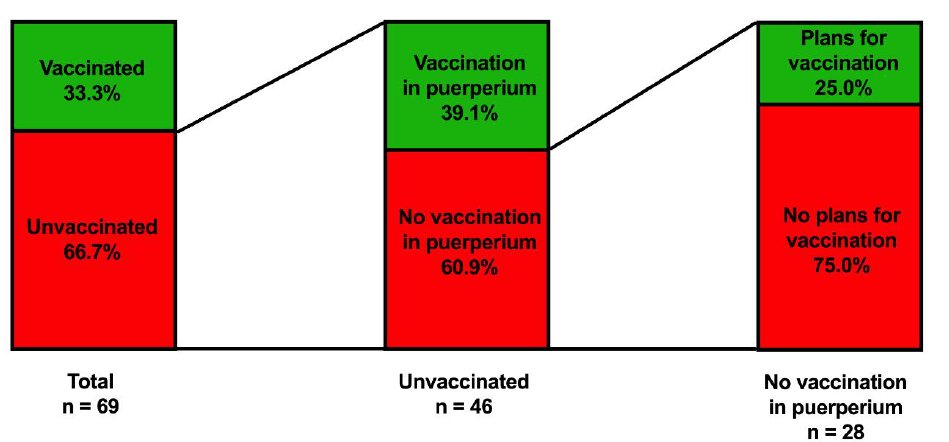
Figure 2. In the evaluation group (n = 69), of women in puerperium, their SARS-CoV-2 vaccination status and willingness to receive the vaccination was assessed via a written questionnaire. Overall, 33.3% were vaccinated with at least one shot, while 66.7% were not vaccinated. Of the n = 46 unvaccinated patients, 39.1% were willing to receive a vaccination during puerperium, whereas 60.9% stated they would decline the SARS-CoV-2 vaccination during puerperium. Of the 28 unvaccinated patients who declined the SARS-CoV-2 vaccination in puerperium, 25% (n = 7) had plans on receiving the SARS-CoV-2 vaccination later on, while 75.0% (n = 21) declined the SARS-CoV-2 vaccination in